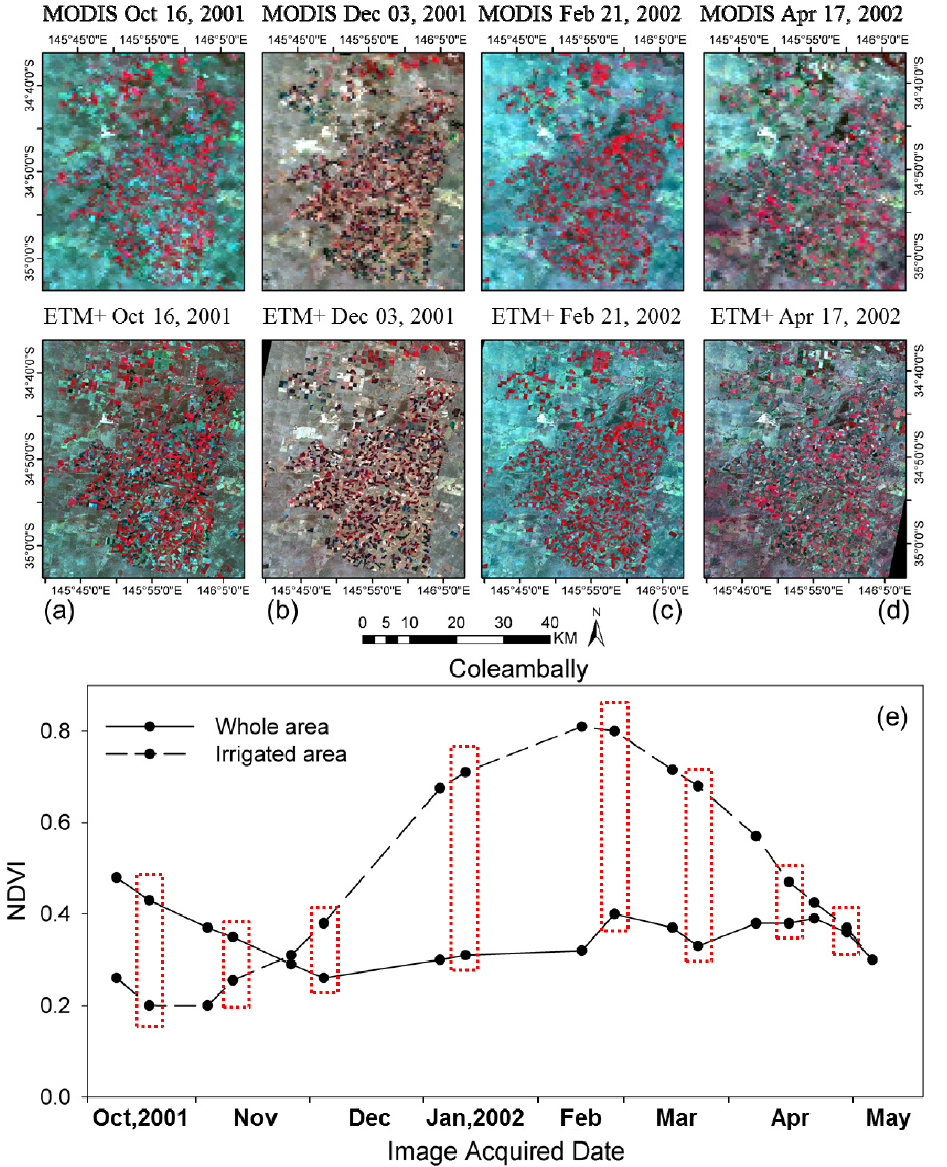
Figure 5. Sample pairs of ETM+ and MODIS data acquired at prediction dates ( a ) 16 October 2001, ( b ) 3 December 2001, ( c ) 21 February 2002, and ( d ) 17 April 2002 (NIR-Red-Green composite and identical linear stretch); and ( e ) the ETM+ NDVI time-series for Coleambally and irrigated area, respectively. All prediction dates are marked by the red dotted